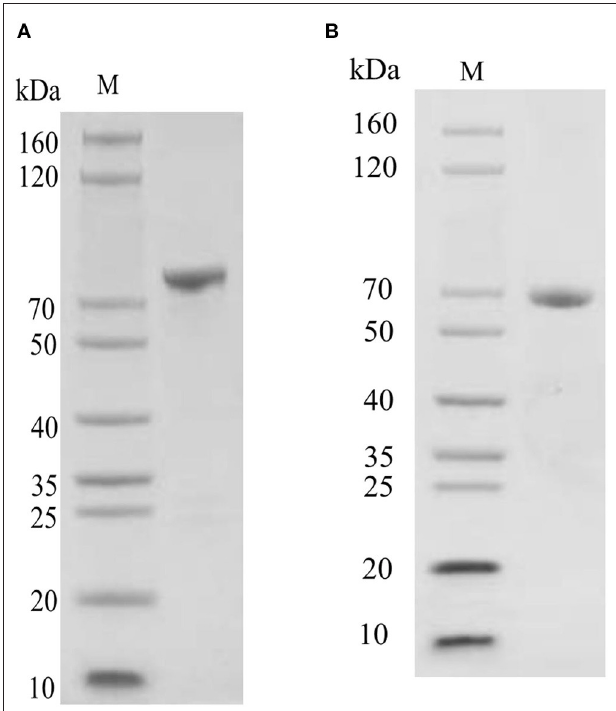
FIGURE 5 | SDS-PAGE detection of recombinant protein. (A) SDS-PAGE detection of pGEX-4T-Oct4 protein. (B) SDS-PAGE detection of pET30a-Sox9 protein. M,